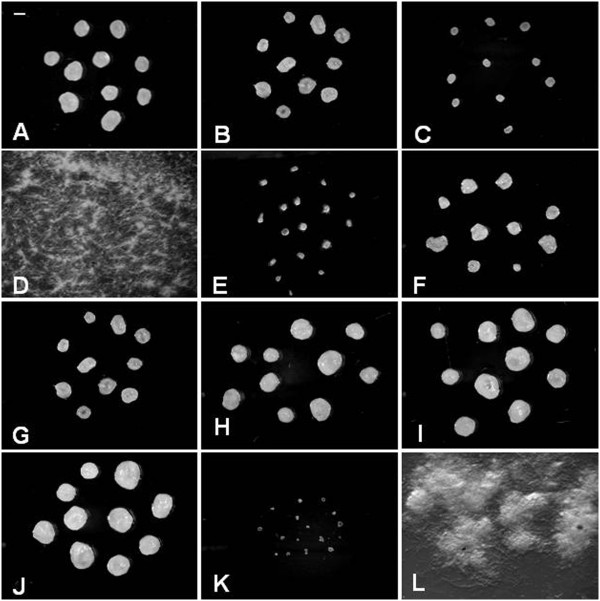
Macroscopic morphology of A. niger MYA 135 in submerged fermentation. Pictures show fungal mycelia developed in basic medium at 25°C (A), 30°C (B), 37°C (C), pH 2(D), pH3 (E), pH4 (F), pH5 (G), pH6 (H), pH7 (I) and pH8 (J) as well as those obtained in the presence of either 0.5 g l-1 CaCl2 (K) or 1.0 g l-1 FeCl3 (L). Bar represents 1 mm. These images were taken after 72 h of cultivation.